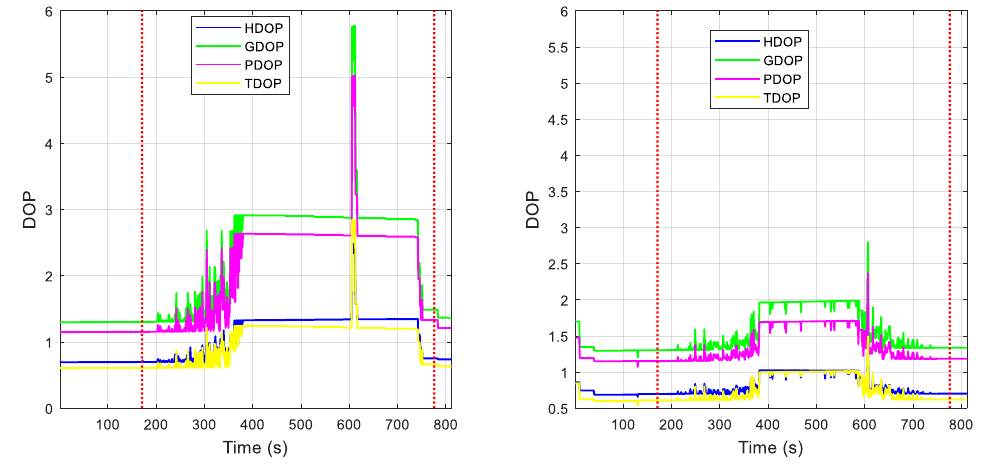
Figure 15. DOP values. ( Left figure )—scenario #5, ( right figure )—scenario #6.